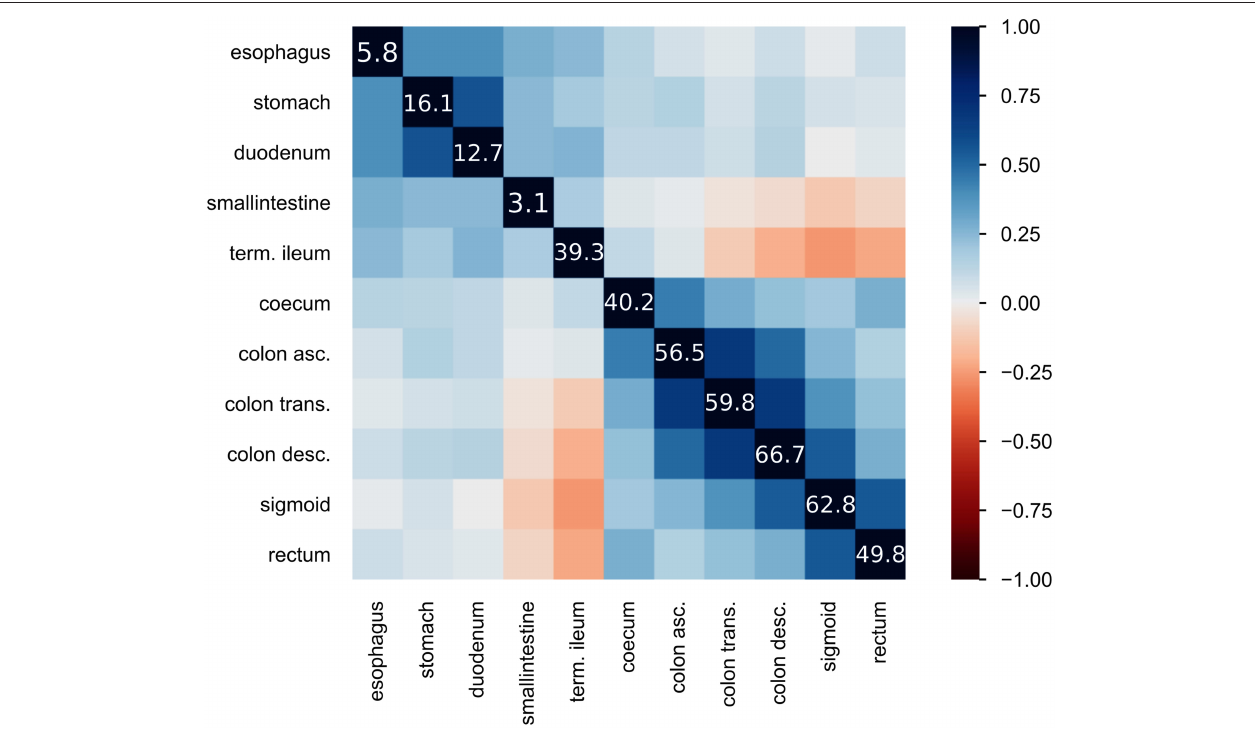
FIGURE 2 | Heatmap of inflammatory locations : displays the correlation of observed inflammations in the given locations. Correlation is visualized using Pearson’s “r” coefficient. Additionally, the diagonal line of values shows the frequency of inflammation observed at the location in percent.